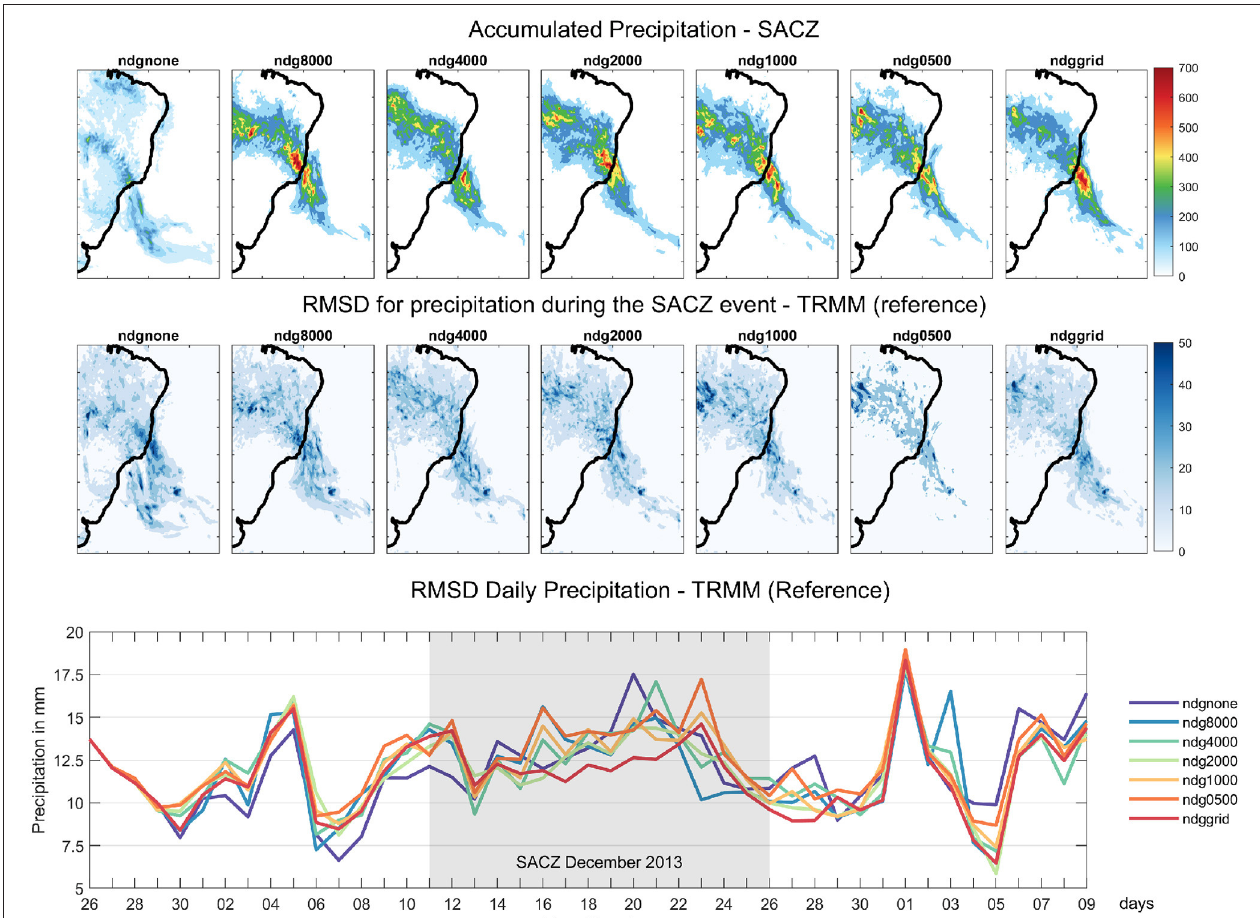
FIGURE 9 | Accumulated precipitation maps (Top) for all experiments during the SACZ event, RMSD maps for precipitation values during the SACZ event (Middle) and time series of RMSD values during the whole simulated period (Bottom) . All RMSD calculations are based on TRMM dataset as the observational